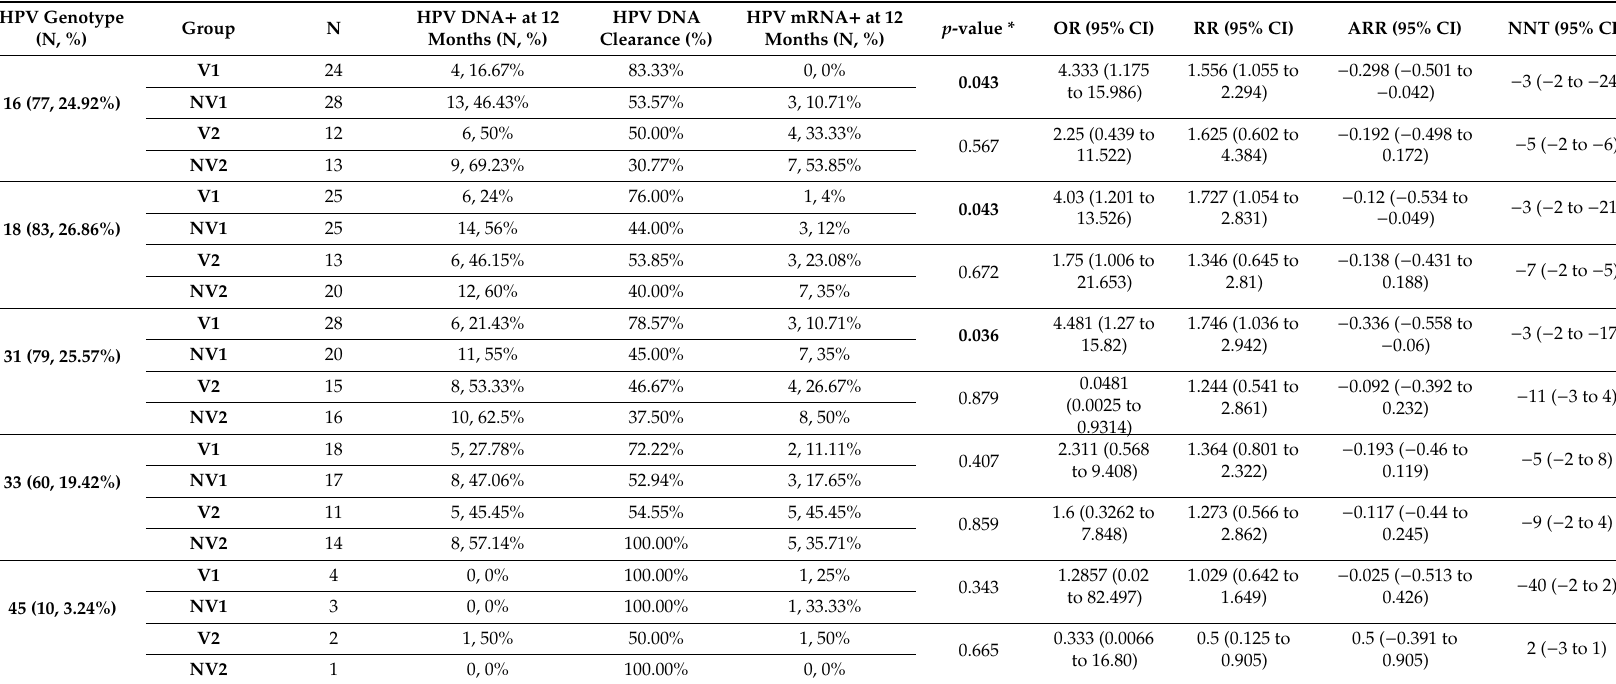
Table 3. Evolution of HPV-related infections in the study period depending on specific HPV genotype. Analytical results of the studied groups. All cases were positive for the specified HPV subtype (16, 18, 31, 33, or 45) before vaccination. N: number of cases within each study group, OR: odds ratio, RR: relative risk, ARR: absolute relative risk, NNT: number needed to treat, CI: confidence interval, V1: vaccinated women with HPV DNA-positive and mRNA-negative results, NV1: non-vaccinated women with HPV DNA-positive and mRNA-negative results, V2: vaccinated women with HPV DNA- and mRNA-positive results, NV2: non-vaccinated women with HPV DNA- and mRNA-positive